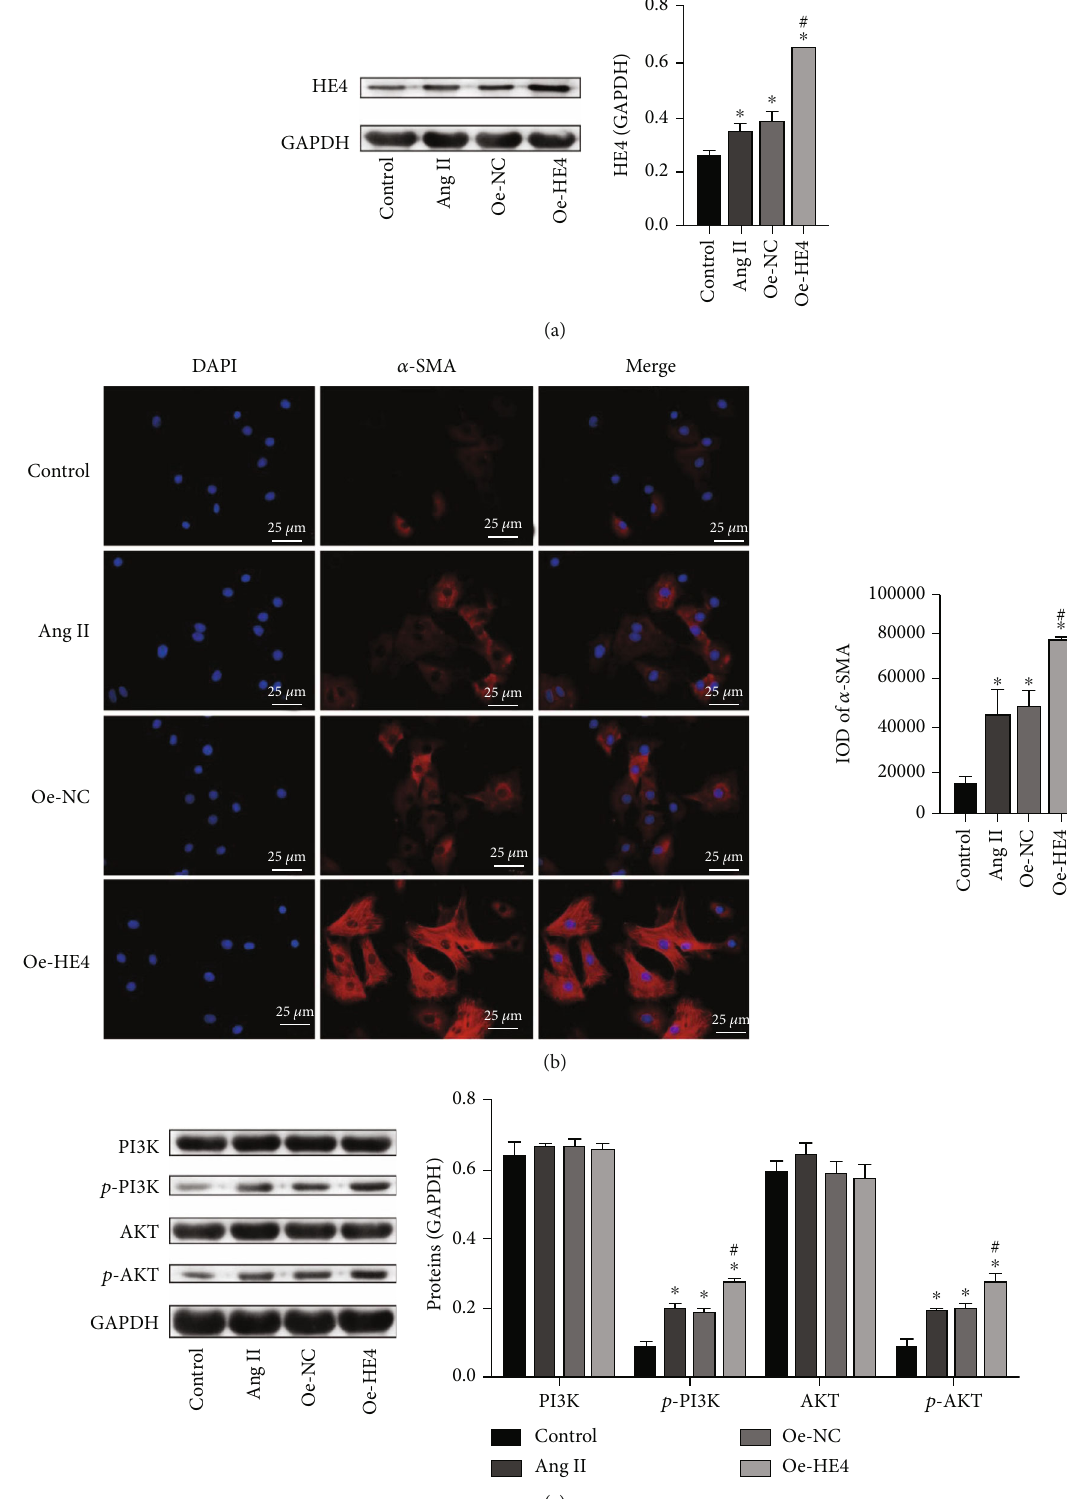
Figure 5: HE4 promoted myocardial fi broblast fi brosis and activated the PI3K/AKT pathway. (a) Western blot was applied to test HE4 expression. (b) α -SMA expression was detected by IF ( × 400, 25 μ m). (c) Western blot was used to examine PI3K, p-PI3K, ATK, and p- AKT levels. ∗ P < 0 : 05 vs. control; # P < 0 : 05 vs.